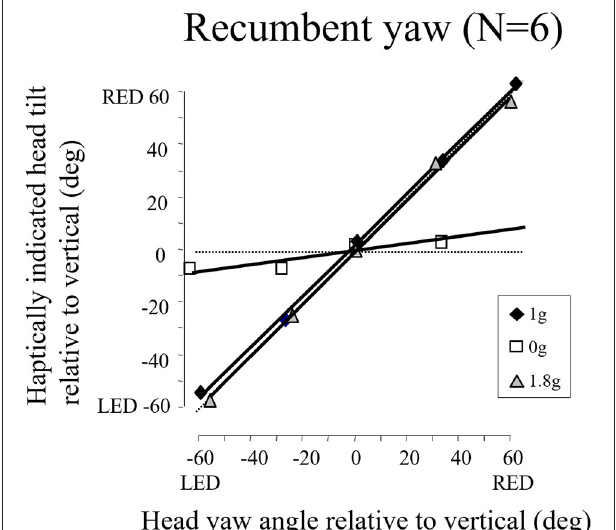
FIGURE 15 | Recumbent subjects ( N = 6) indicated the amplitude of imposed passive yaw-axis rotations during the 0 and 1.8g phases of parabolic flight maneuvers and in straight-and-level flight. Rotations were 30 ◦ or 60 ◦ in amplitude and lasted < 1.5s. Subjects used a gravity neutral pointer and tried to keep it aligned with their start position. In 0g, rotations were greatly underestimated. Similar results were obtained for vertical yaw axis rotation in